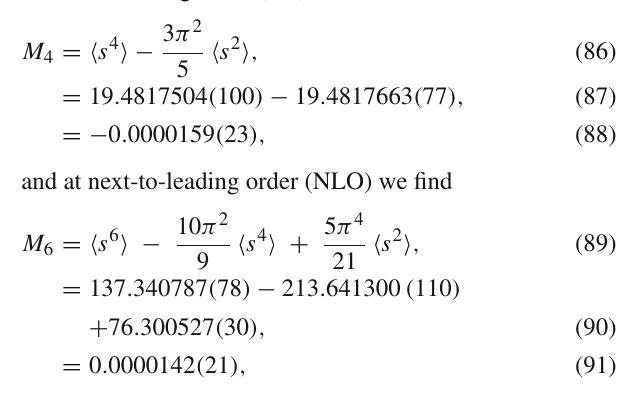
Fig. 7 Thehighestelement y n asafunctionoftheorder n oftheexpan- sion